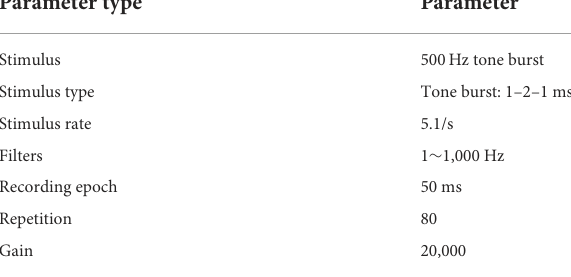
TABLE 1 Parameter setting of oVEMP in this